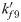
Varying rates of site-specific phosphorylation and dephosphorylation drive mitotic exit.(A) Simulation of PPase phosphatase (i.e. PP2A) and MPF kinase (CCNB1:CDK1) in regulating activation of APC/CP:CDC20 and APC/CT:CDH1 over the indicated time periods with sequential loses in CCNB1T, MPF, PPaseP, APC/CP:CDC20 and APC/CT:CDH1. Boxed area is magnified, and arrow identifies the approximate onset of APC/C:CDC20 activation. (P, phosphorylated protein; T, total protein) (B) MPF and PP2A substrate preferences for S (serine) and T (threonine), respectively, drive mitotic progression. This includes MPF-dependent slower phosphorylation of CDC20 (k′r9) and faster phosphorylation of APC/C (k′f8) and CDH1 (k′r11), and faster PP2A-dependent dephosphorylation of CDC20P (k′f9) and slower dephosphorylation of APC/CP (k′r8) and CDH1P (k′f11). (C) Simulated increases in PP2A-dependent dephosphorylation of CDC20P (kf9′) result in increased oscillations of active MPF kinase occurring when kr9′ is high. (D) Simulated increases in PP2A-dependent dephosphorylation of APC/CP (kr8′) and CDH1P (kf11′) result in loss of oscillations of active MPF kinase when kr8′ and kf11′ are high, respectively.